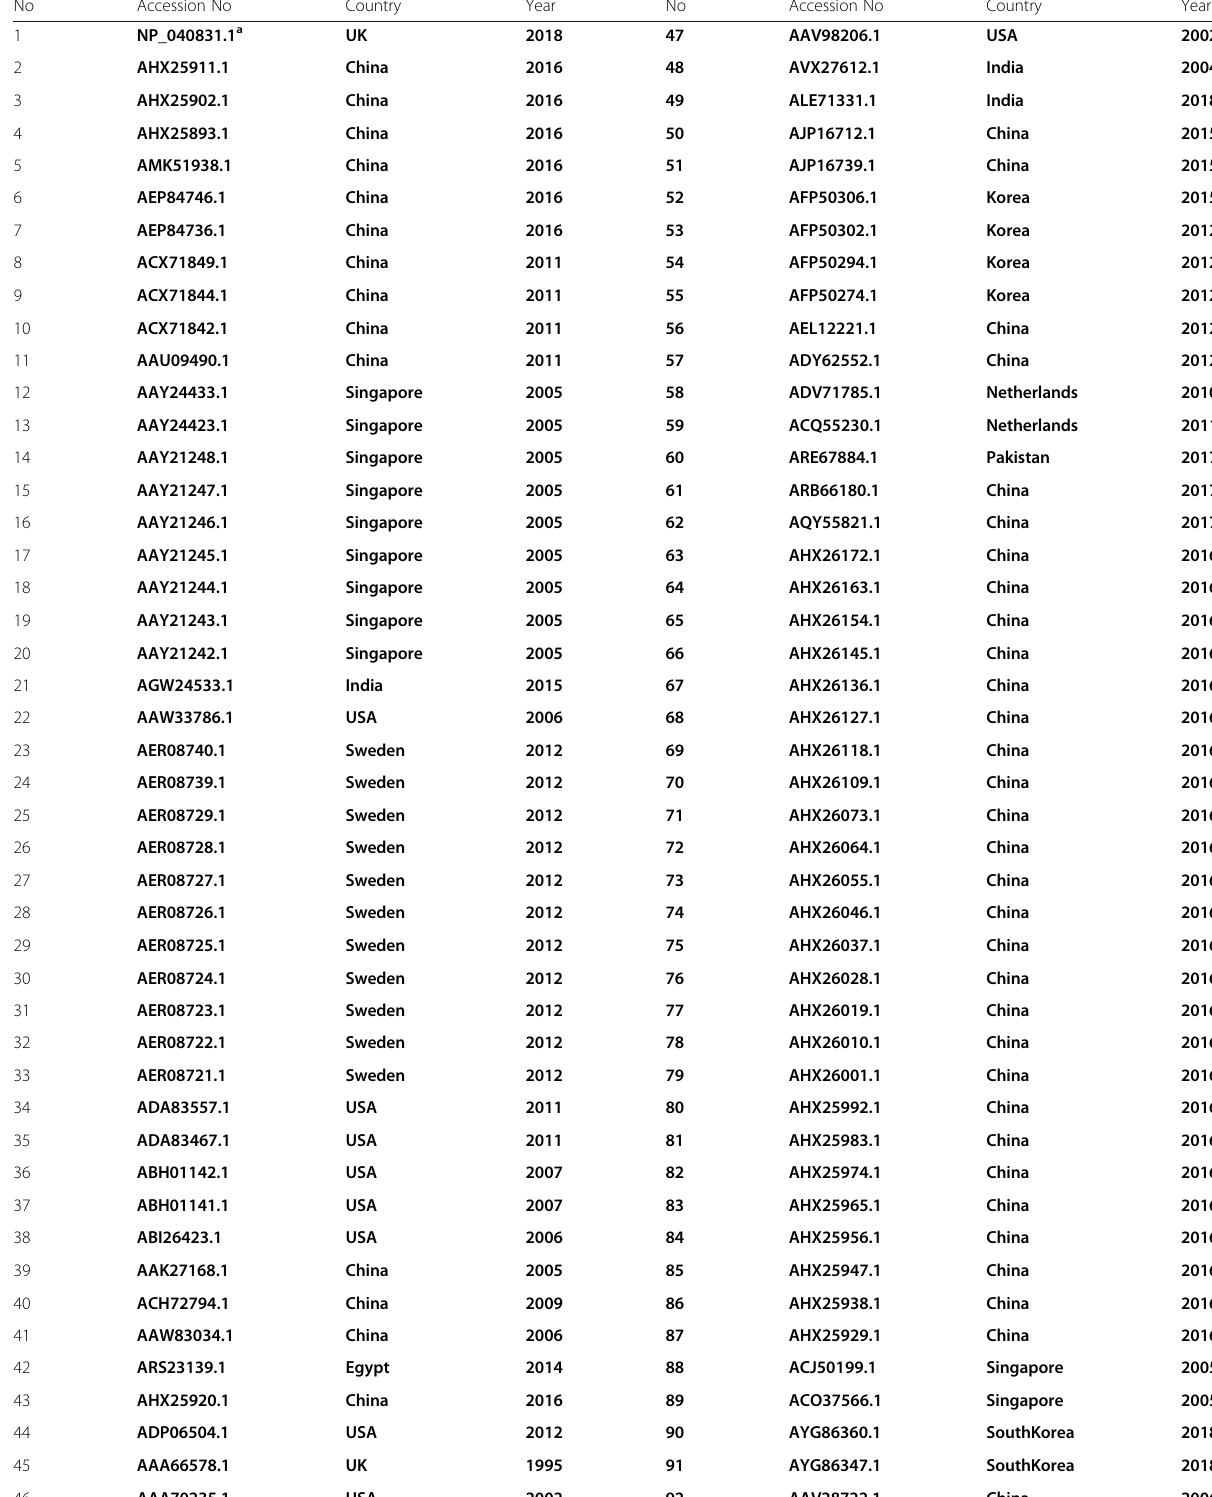
Table 1 Accession numbers, date and area of collection of the retrieved sequences of Spike protein of